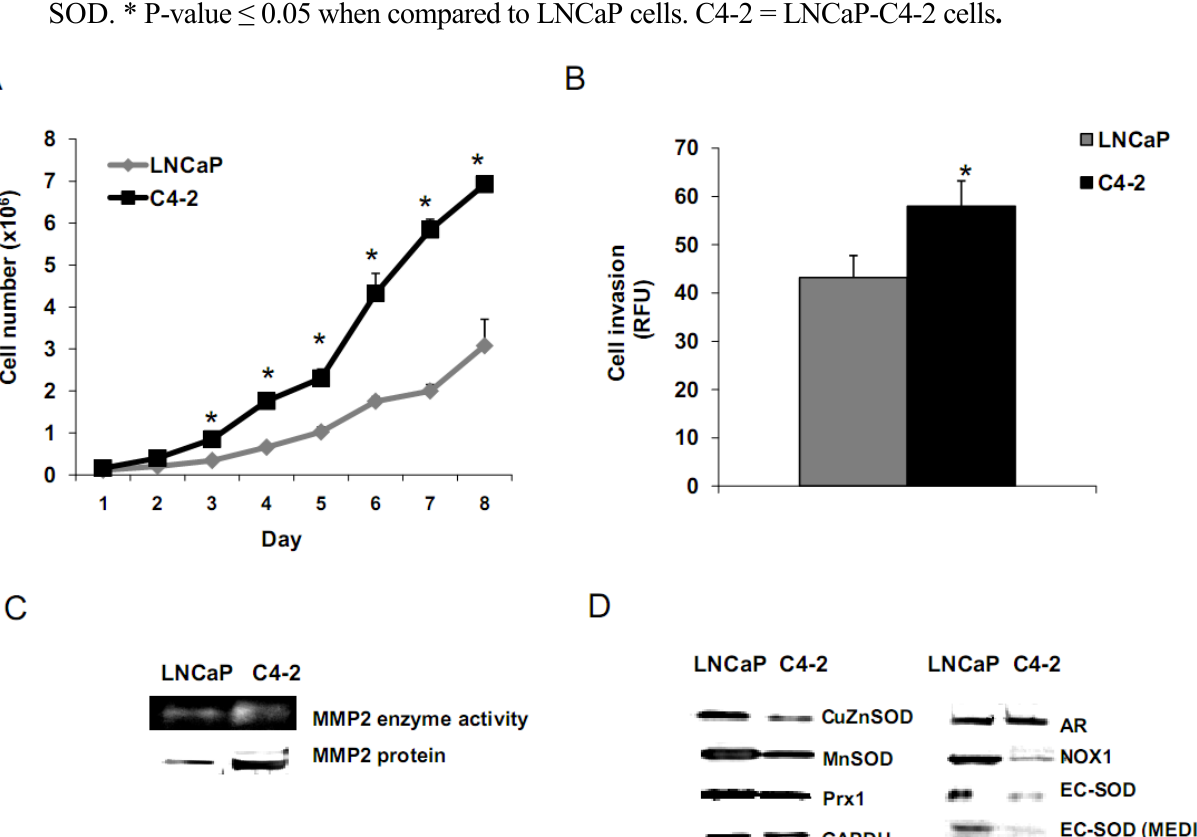
Figure 8. Biology and redox related protein expression of LNCaP or LNCaP-C4-2 cells. ( A ) Growth curves. Cells were seeded at 7 × 10 4 cells in 60 mm dishes and counted every 24 h; ( B ) Invasion ability and ( C ) MMP activity (zymography) and protein level (western blot analysis). Cells were cultured for 24 h in RPMI medium without serum prior to analysis. Cells were collected for invasion assay and conditioned media were collected for MMP2 zymography. For invasion assay, after incubation for 24 h, cells that had